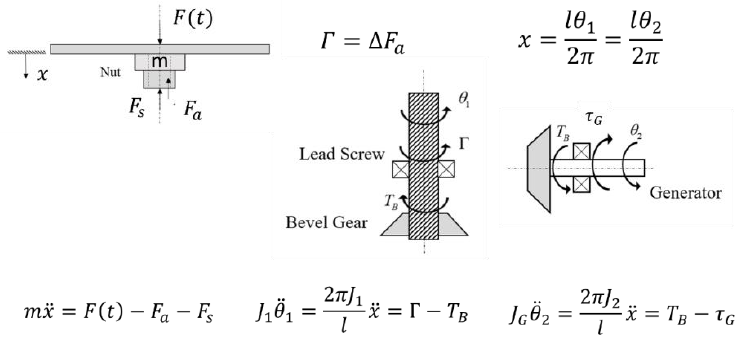
Figure 6. Lead-Screw Free Body Diagram.